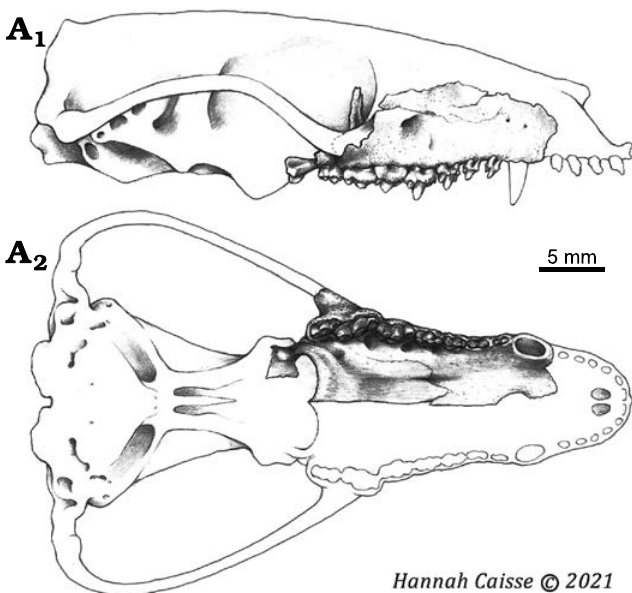
Fig. 3. Hypothesized life position of the skull fragment (OMNH 80538) of the morganucodontan mammaliaform Cifellilestes ciscoensis gen. et sp. nov., in lateral (A 1 ) and ventral (A 2 ) views. Remainder of the skull based on the composite restoration of Morganucodon by Kermack et al. (1981). Artwork by Hannah